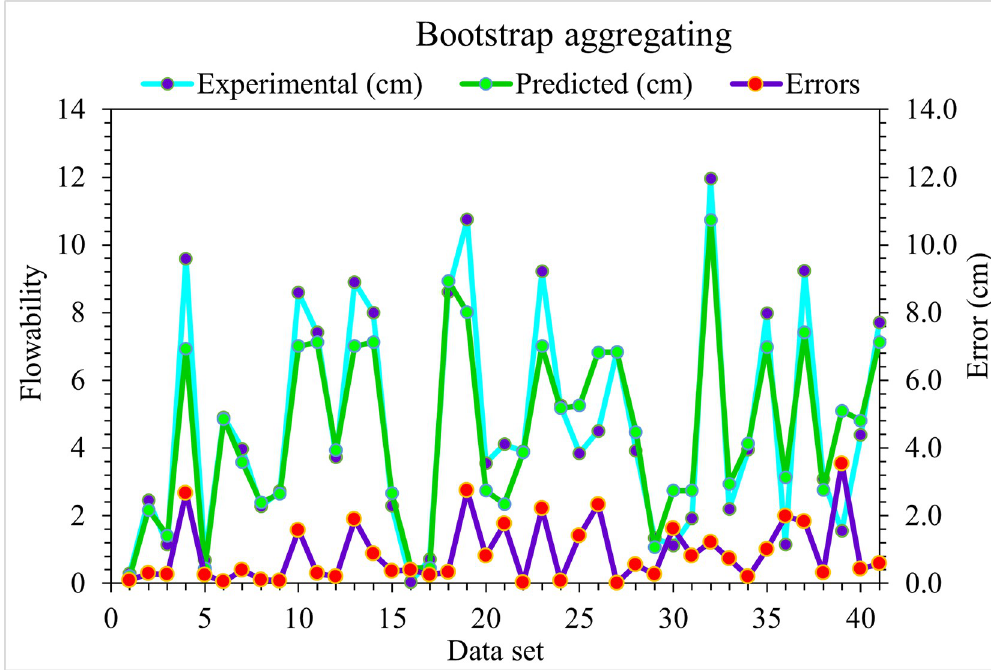
Fig 13. BA predicted and experimental error values—UHPC flowability.